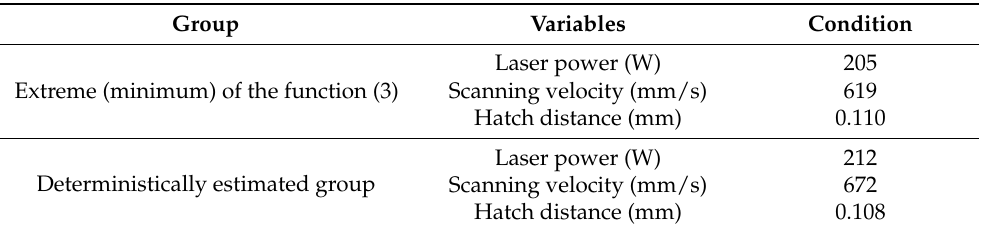
Table 4. Process parameter values were obtained by following the statistical model based on the results of the first experiments.